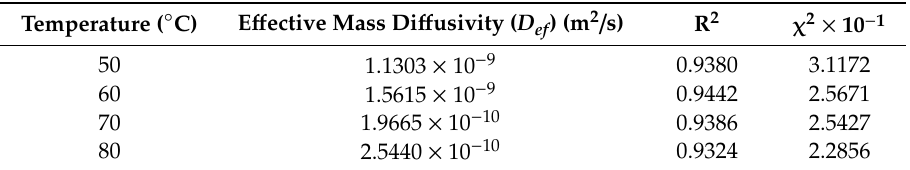
Table 1. E ff ective mass di ff usivity for model 3.